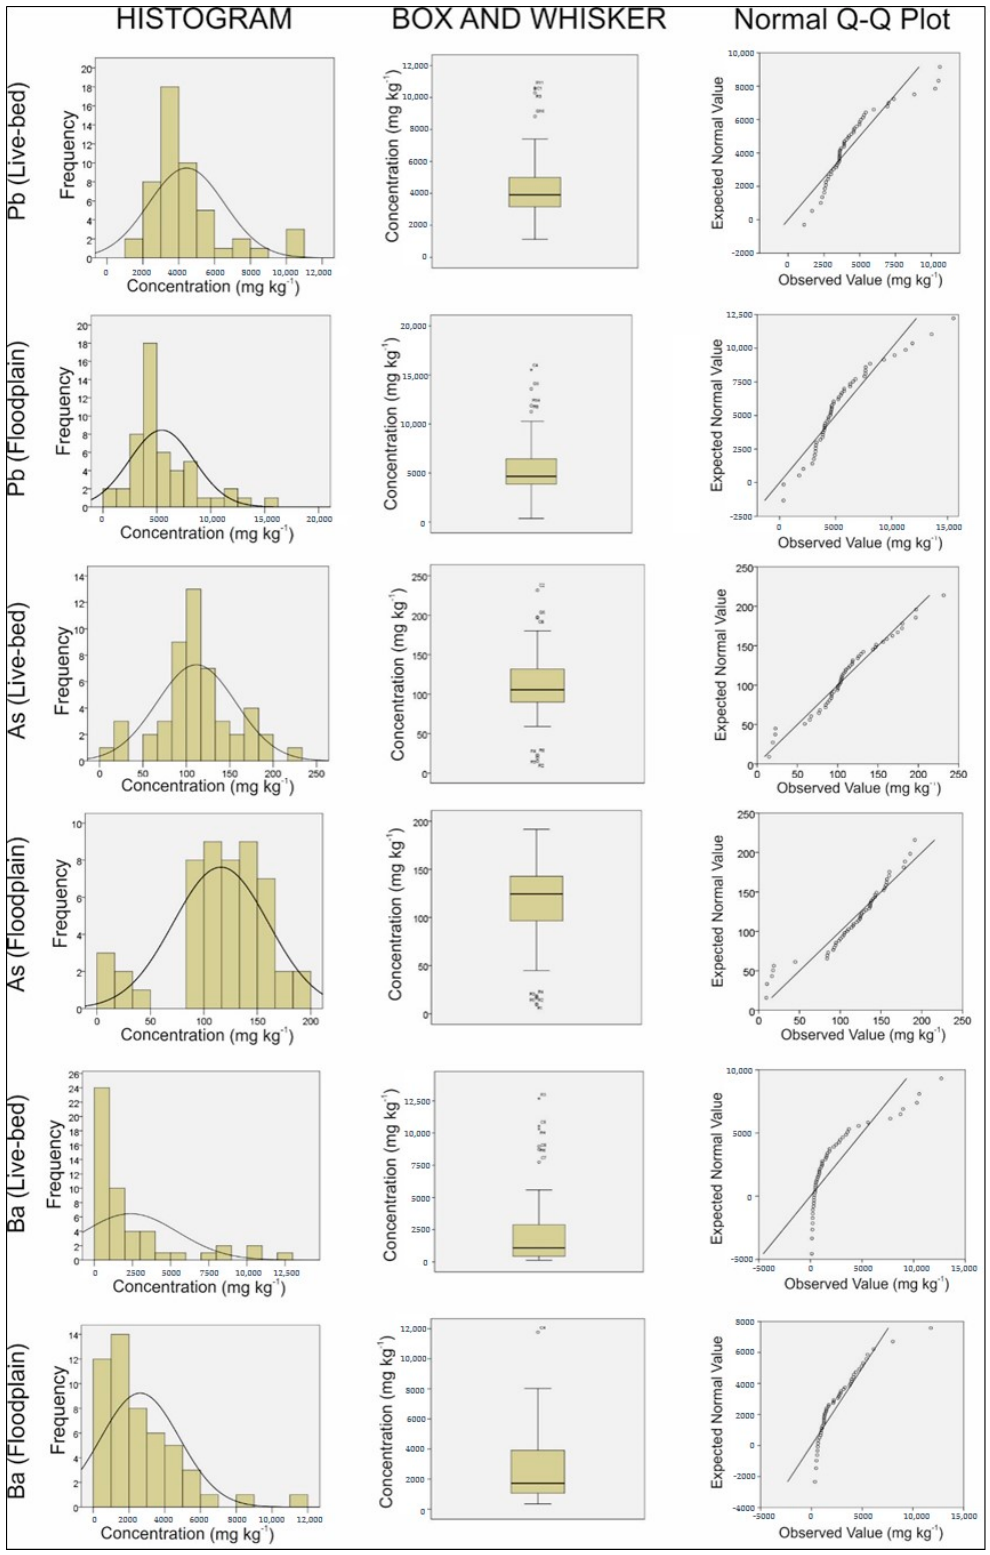
Figure 4. Histograms box-and-whisker plots and normality curves for Pb As and Ba. A multivariate analysis by principal components with varimax rotation was performed for the sediment samples obtained in the live-bed channel and in the floodplain. The total variance explained